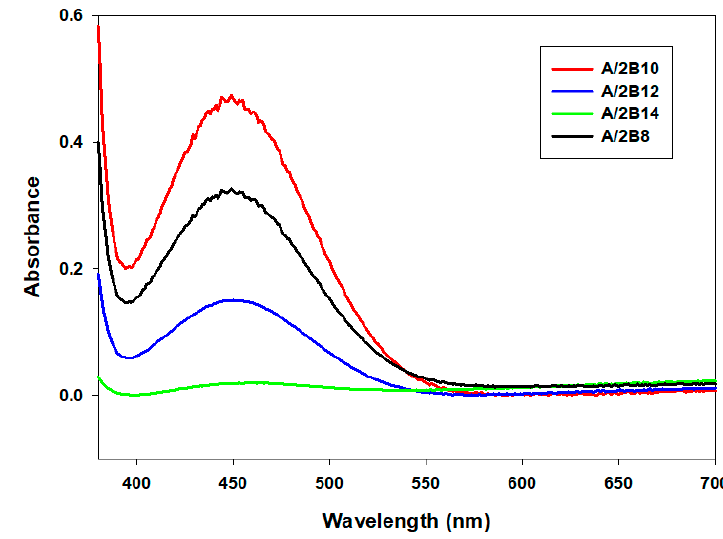
/ 2Bn , in chloroform.